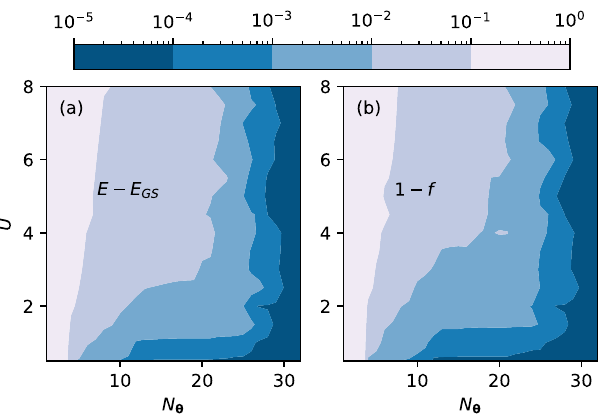
Fig. 4 Error and state fi delity analysis of qubit adaptive derivative- assembled pseudo-trotter (ADAPT) ansatz. a Log-scale contour plot of the variational energy error E − E GS of the qubit-ADAPT ansatz as a function of N θ and Hubbard U for the (2, 2) e g impurity model. Here, E GS is the exact ground state energy and E is the converged variational energy. b State